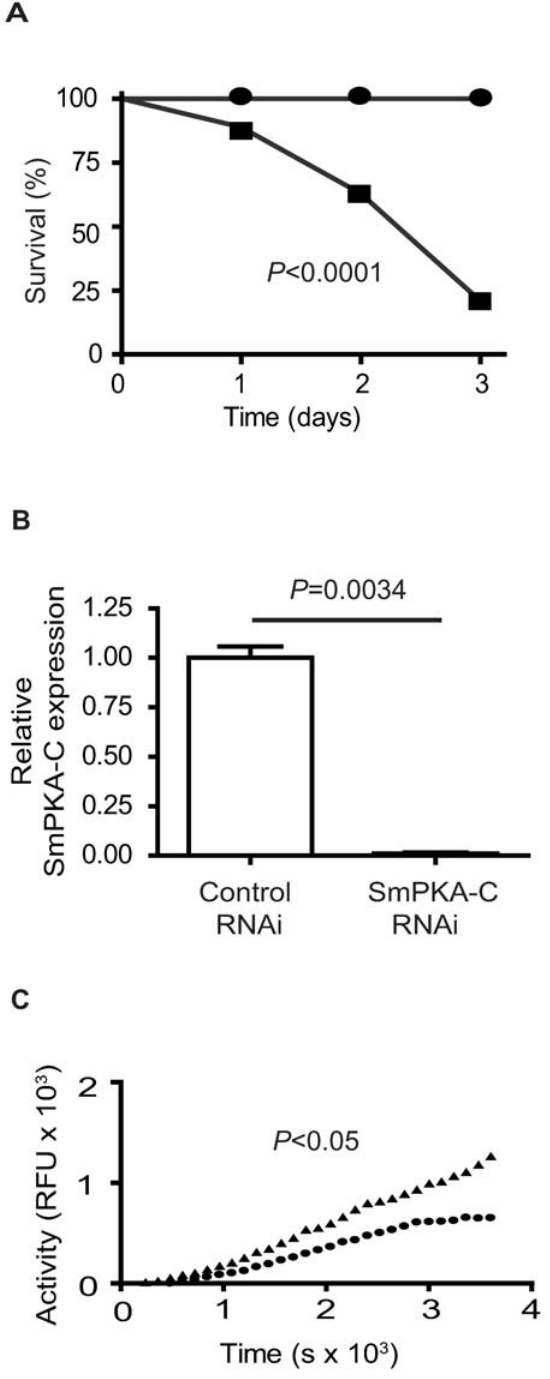
Figure 5. SmPKA-C encodes for an essential kinase activity. A, N Electroporation of adult worms with 30 m g of SmPKA-C dsRNA ( & ) ) resulted in 75% mortality while worms treated with control dsRNA ( exhibited 100% survival. B, Three days after electroporation, SmPKA-C transcript levels were decreased in worms electroporated with 10 m g of SmPKA-C dsRNA, while transcript levels were unaffected in control N dsRNA-treated worms, as determined by real-time PCR. C, 7 days after ) and control dsRNA- electroporation, SmPKA-C dsRNA-treated ( treated worms ( m ) were incubated for 2 h in 100 m M forskolin. PKA activity was significantly decreased after electroporation with 10 m g SmPKA-C dsRNA compared to control dsRNA-treated worms.